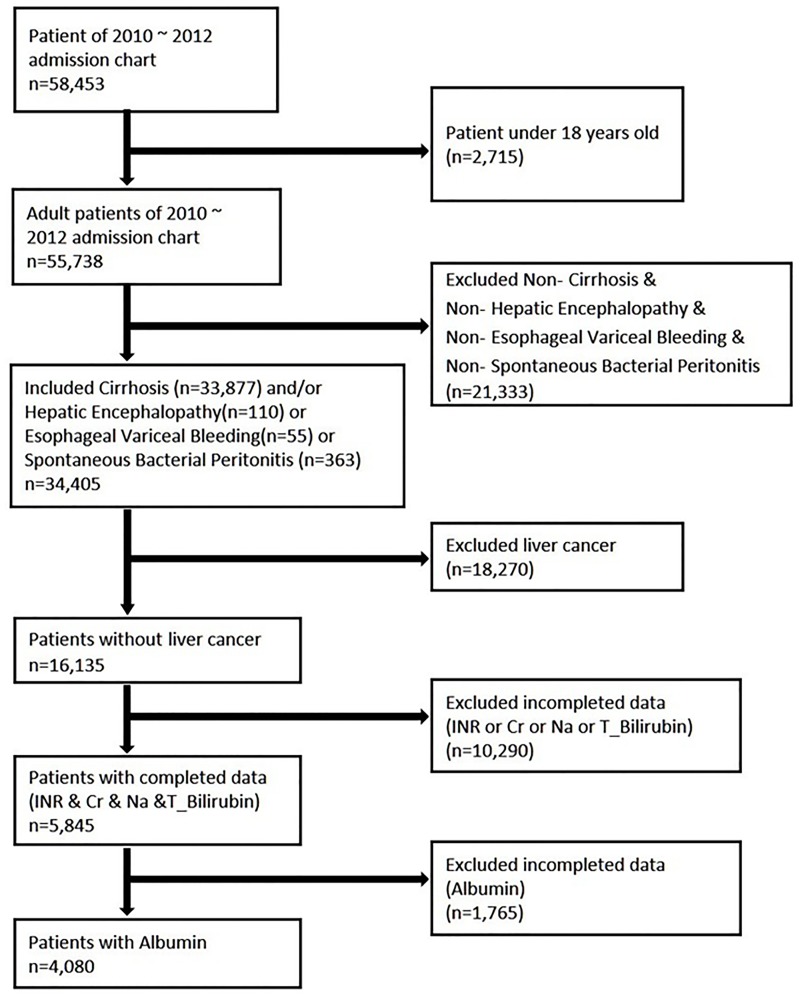
Flow chart of patients included in the study (n = 4080).